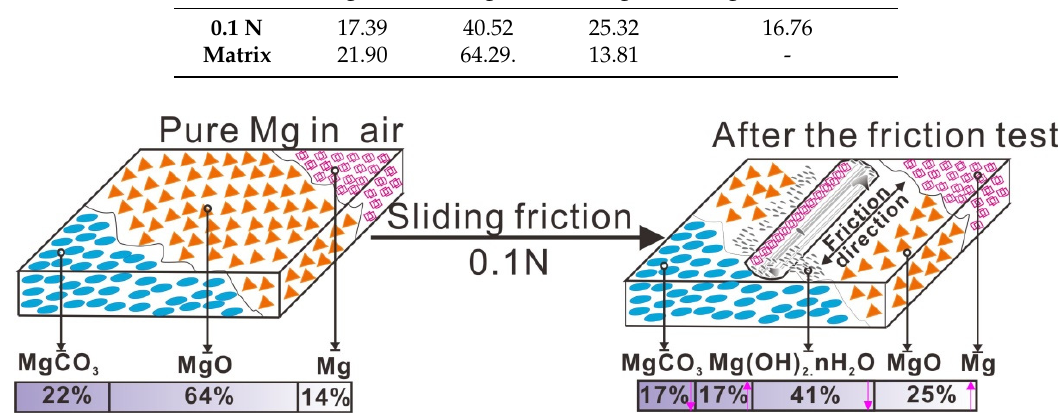
Figure 12. Tribo-chemical behavior during sliding friction.